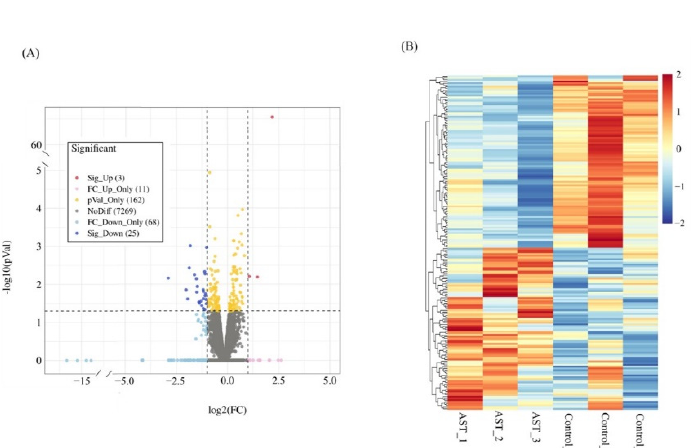
Figure 2. Volcano plot and heatmap of genes altered by astaxanthin treatment in C. elegans . ( A ) Volcano plot. Each point represents a single gene. Plotted along the x-axis is the log2(FC) of each gene (comparison of gene expression in astaxanthin-treated worms with the untreated worms). The y-axis represents the negative logarithm of the corresponding p -value of that gene. Up- and down-regulated (3 and 25, respectively) genes with p < 0.05 and |log2FC| ≥ 1 are shown in red and blue, respectively, whereas genes showing no differential expression are shown in grey. Up- and down-regulated (11 and 68, respectively) genes with |log2FC| ≥ 1 but p ≥ 0.05 are shown in light red and light blue, respectively, and 162 genes changed significantly, but with |log2FC| < 1, and are shown in yellow. ( B ) Heatmap of significantly changed genes. Color correlates with the value of z-score. Z-score = (X − mean)/SD. AST,